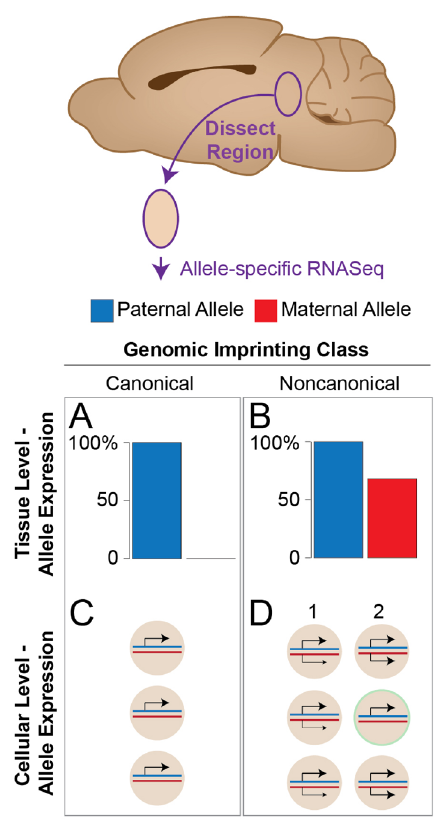
Figure 1. Schematic depiction of canonical versus noncanonical genomic imprinting identified in the mouse. Canonical and noncanonical imprinting was characterized in different mouse tissues by using RNA-Seq in which allele expression was profiled in a piece of tissue dissected from the brain or in another tissue. ( A ) In this chart, canonical imprinting manifests as complete silencing of one parent’s allele (silent maternal allele shown). ( B ) In contrast, noncanonical imprinting manifests as a significant bias to express one parental allele at a higher level than the other parental allele (paternal allele bias shown). ( C ) At the cellular level, canonical imprinting involves complete silencing of one allele in all cells expressing the gene. ( D ) Noncanonical imprinting may involve either (1) an allelic bias in each cell or (2) allele silencing in a subpopulation of cells in the tissue. Distinguishing between these models (1 versus 2) is an active area of